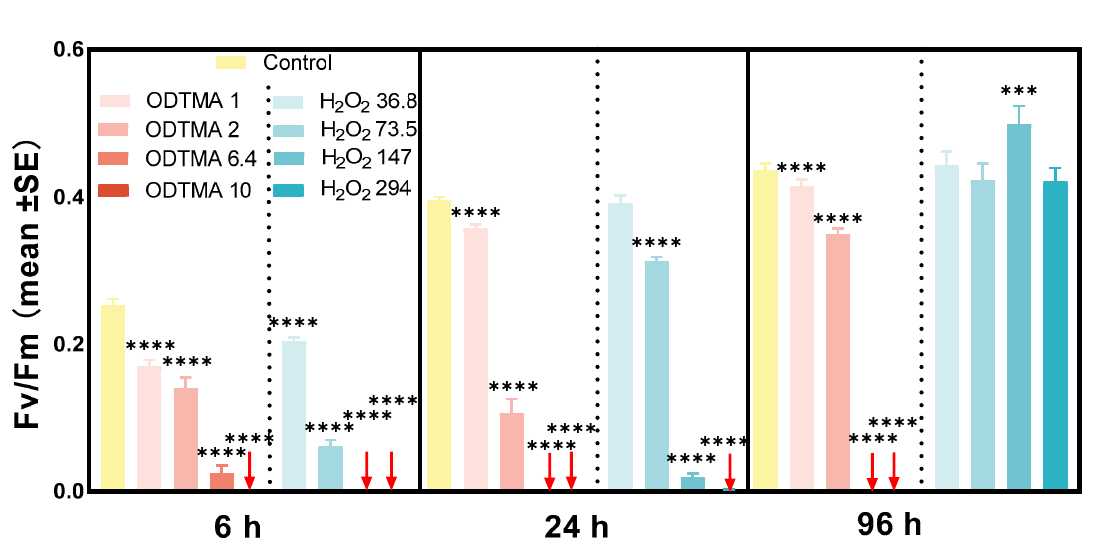
Figure 3. Photosynthetic activity changes (Fv/Fm) of site-collected Microcystis spp. colonies under ODTMA-Br (C18) and H 2 O 2 treatments. Four concentrations of treatment were set for both ODTMA-Br (C18) (1, 2, 6.4 and 10 µ M) and H 2 O 2 (36.8, 73.5, 147 and 294 µ M). The initial chl a concentration of each group was ca. 300 µ g/L. Error bars indicate the standard deviation (n = 3). The asterisk indicates statistically significant differences in comparison with the control: ***, p < 0.005; ****, p < 0.001. Red arrows indicate the values of Fv/Fm were below the detection limit of the method.